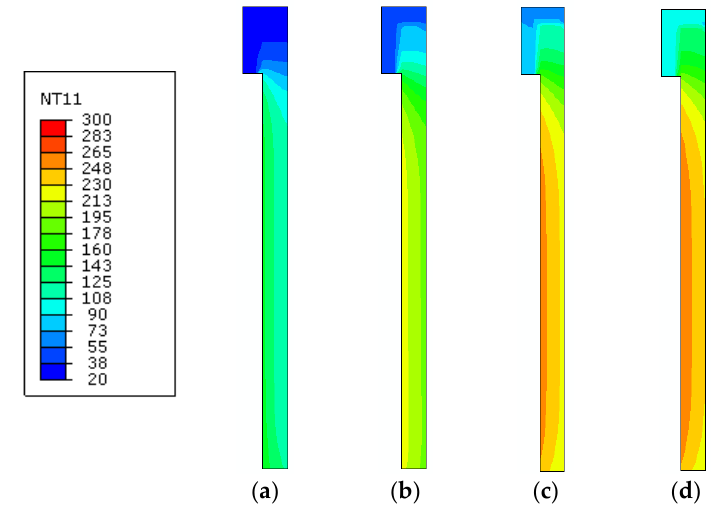
Figure 15. FE results (ABAQUS, 2D) for the MG specimen T2, including mechanical restraints. Temperature history comparisons at the middle and top edge nodes.